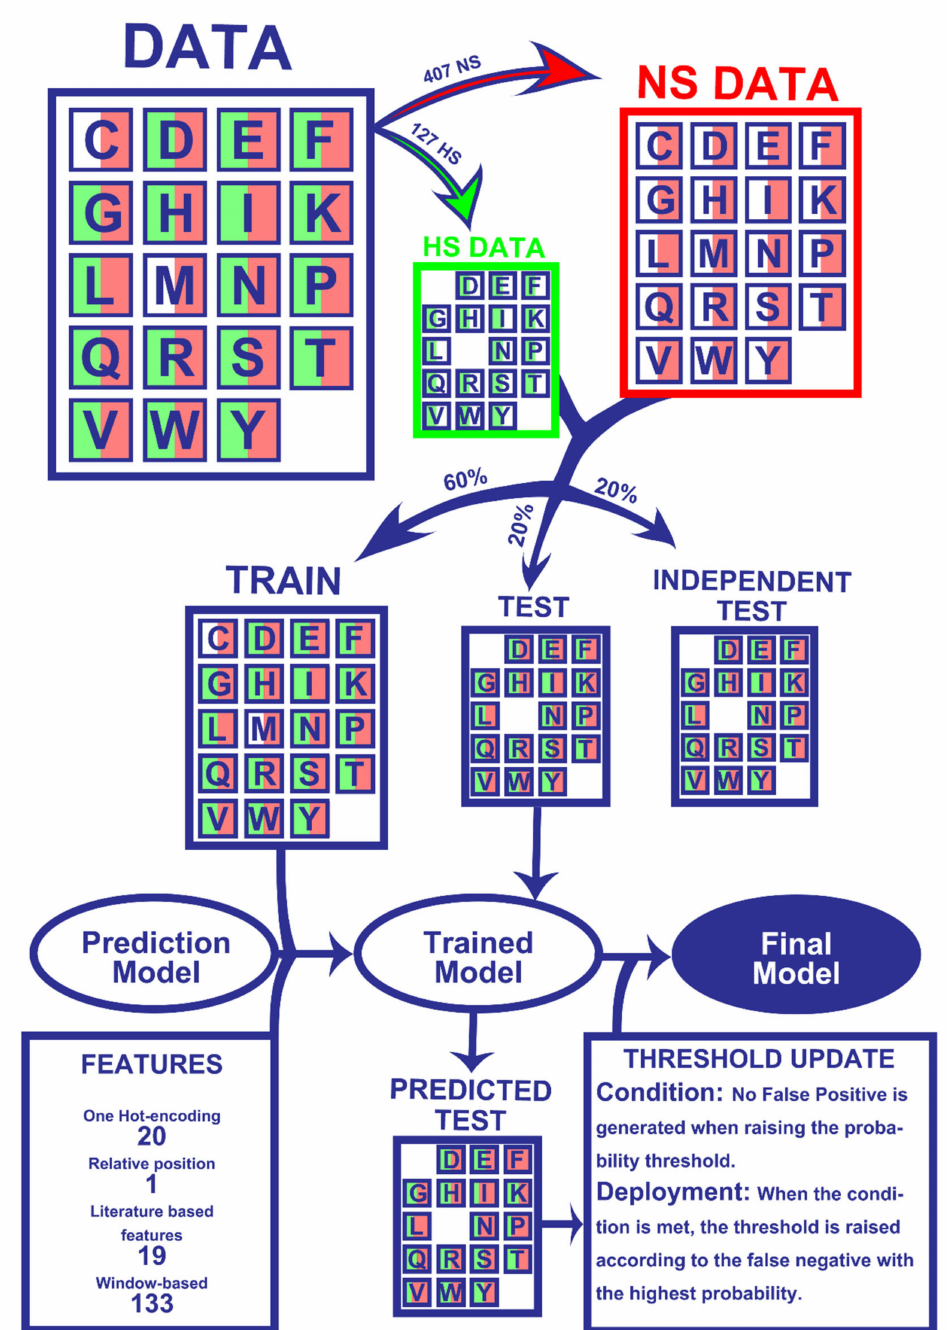
Figure 1. Workflow of the Machine Learning pipeline. Firstly, the 534 amino acids were split into experimentally determined HS (127) and NS (407). Secondly, 60% of the entries of both classes were randomly picked for the train dataset while the remaining 40% were not used for the training phase (20% for test and 20% for an independent test). All datasets were matched with their corresponding 173 features. The training data were used to train the models, which were tested on the test set to yield HS / NS predictions. The predictions were then used to update probability thresholds and generate the final model, which basically consists of the trained model with subsequent HS probability correction. The final model was then applied to an independent test, which did not influence any step of the process, in order to be evaluated. More details on the used method can be found in the Materials and Methods